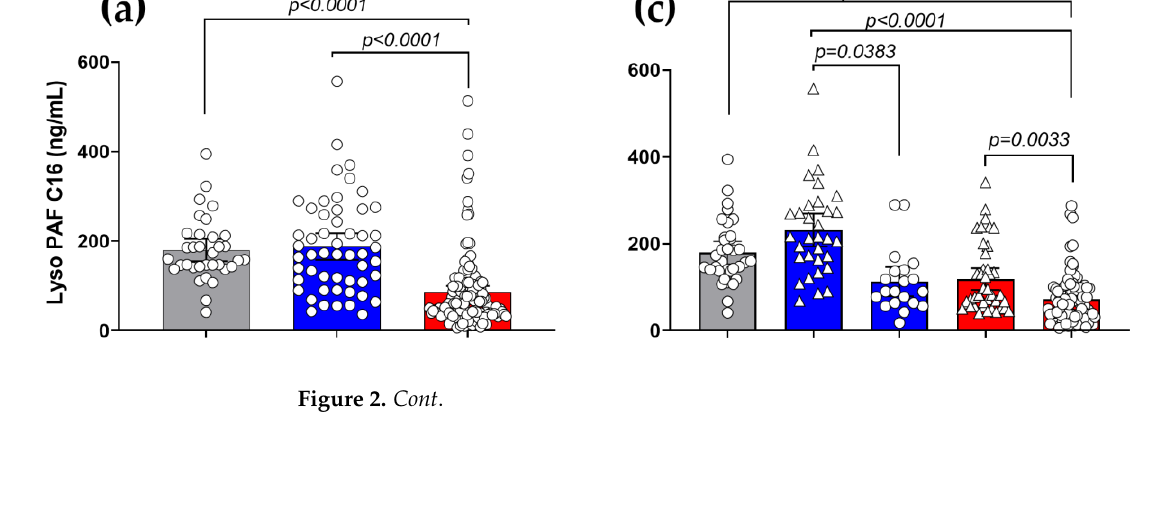
Figure 2. Production of Lyso-PAF C16, PAF C16, and relative abundance of Lyso-PC and Lyso-PE species in COVID-19 patients with the use of GCs. Levels of Lyso-PAF (16:0) ( a ) and PAF (16:0) ( b )